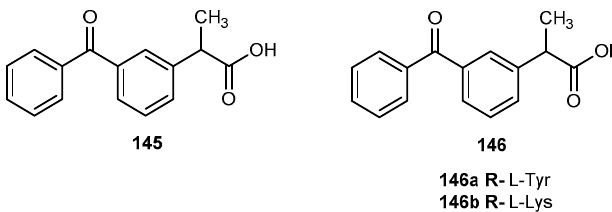
Figure 61. Chemical structures of ketoprofen ( 145 ) and its amino acid prodrugs.